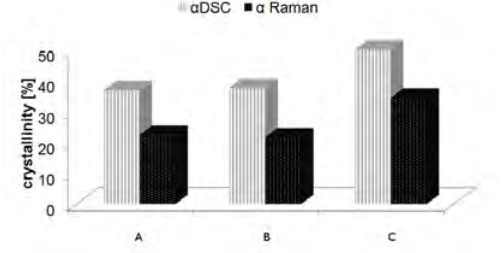
Figure 4. Crystallinity α calculated from Raman spectra and DSC measurements for A non-deformed, B deformed and C highly deformed polypropylene (PP).